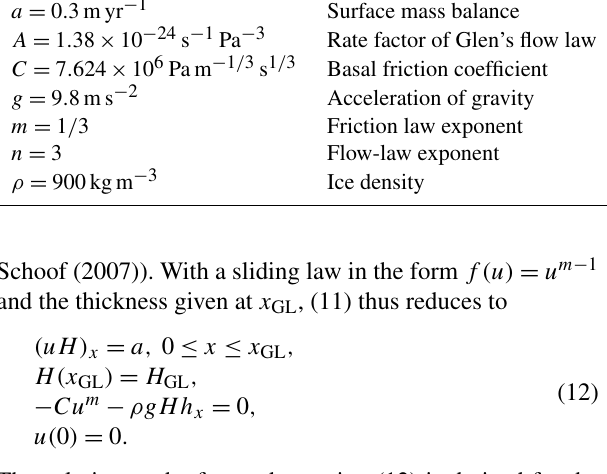
Table 1. The model parameters.